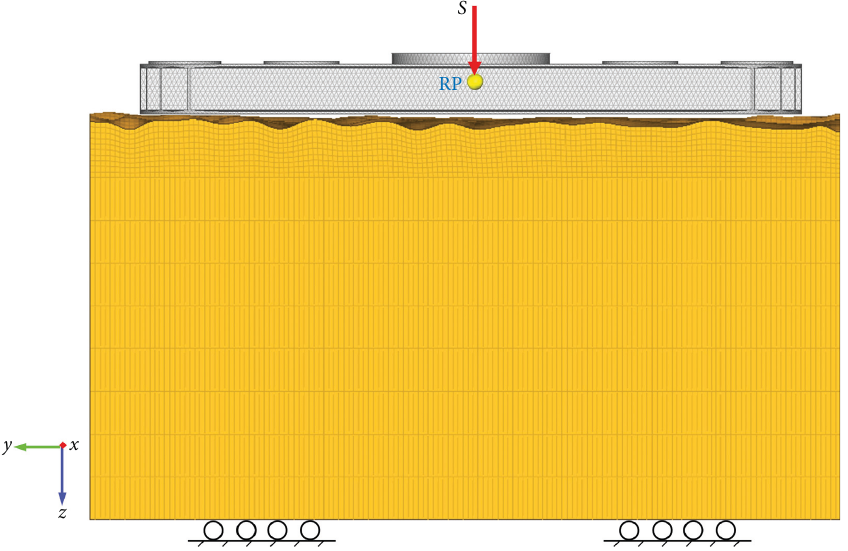
4, G 6 (cid:30) (cid:30)